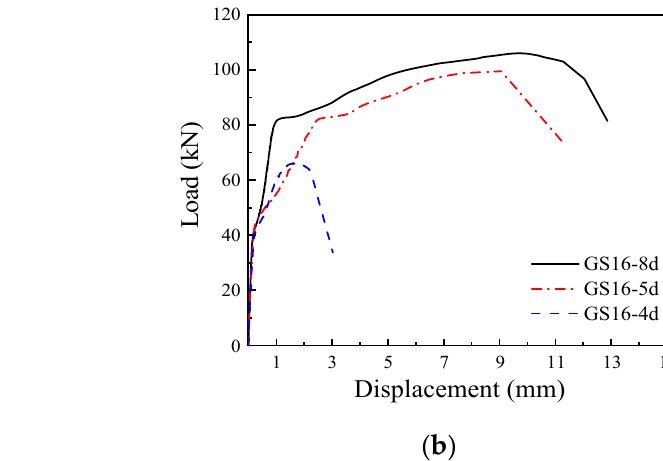
Figure 13. Load–displacement curves of the specimens with different anchorage lengths and grout- ing defects. ( a ) With 5% random defects. ( b ) With 10% random defects.